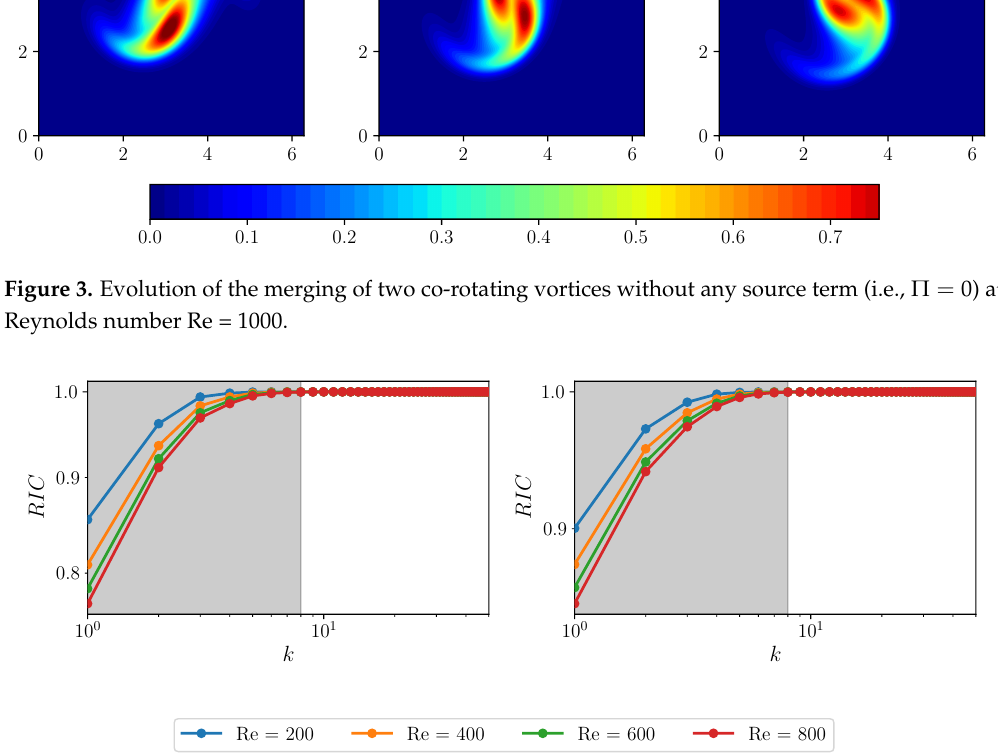
Figure 4. Square of the singular values of the snapshot data matrix A (equivalent to the eigenvalues of AA T or A T A ) for different Re training datasets obtained for the two-dimensional vorticity transport equation with γ = 0.01 ( left ) and γ = 0.1 ( right